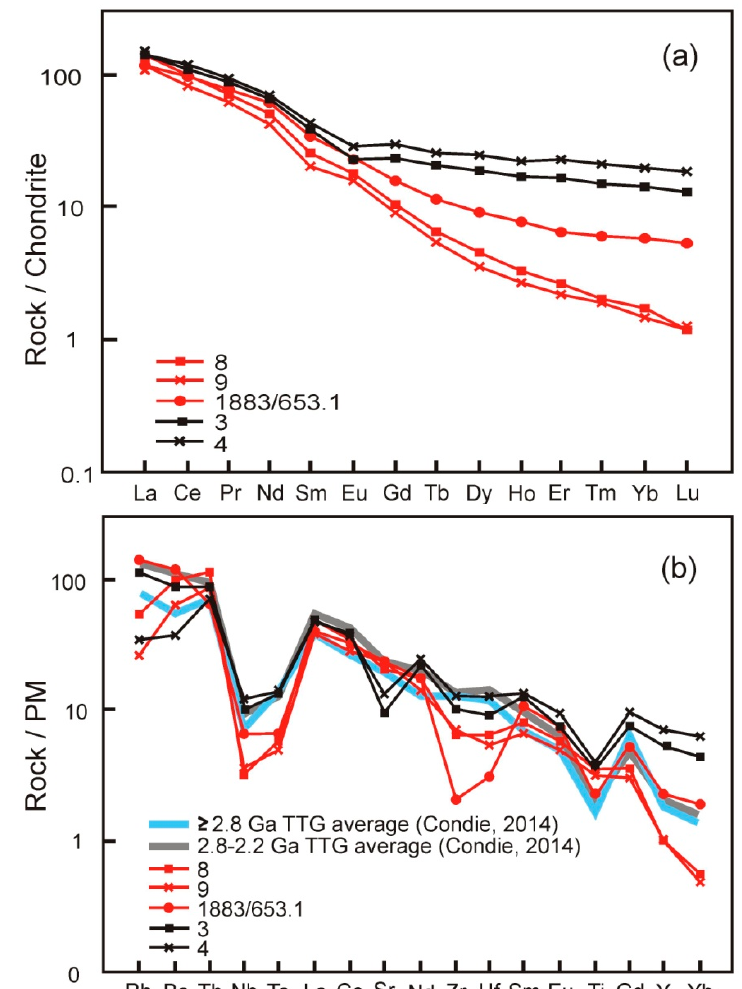
Figure 11. Chondrite normalized rare earth element patterns ( a ) and the primitive mantle normalized trace element diagram ( b ) for diorite-gneisses from the DW block, gneiss from the borehole 1883, metadiorite of the Gabbro-10 massif, and average data for tonalite-trondhjemite-granodiorite rocks (TTG) [23]. Normalization factors from [27,28]. Numbers 3, 4, 8, and 9 (see Table 5) are from the literature [13].